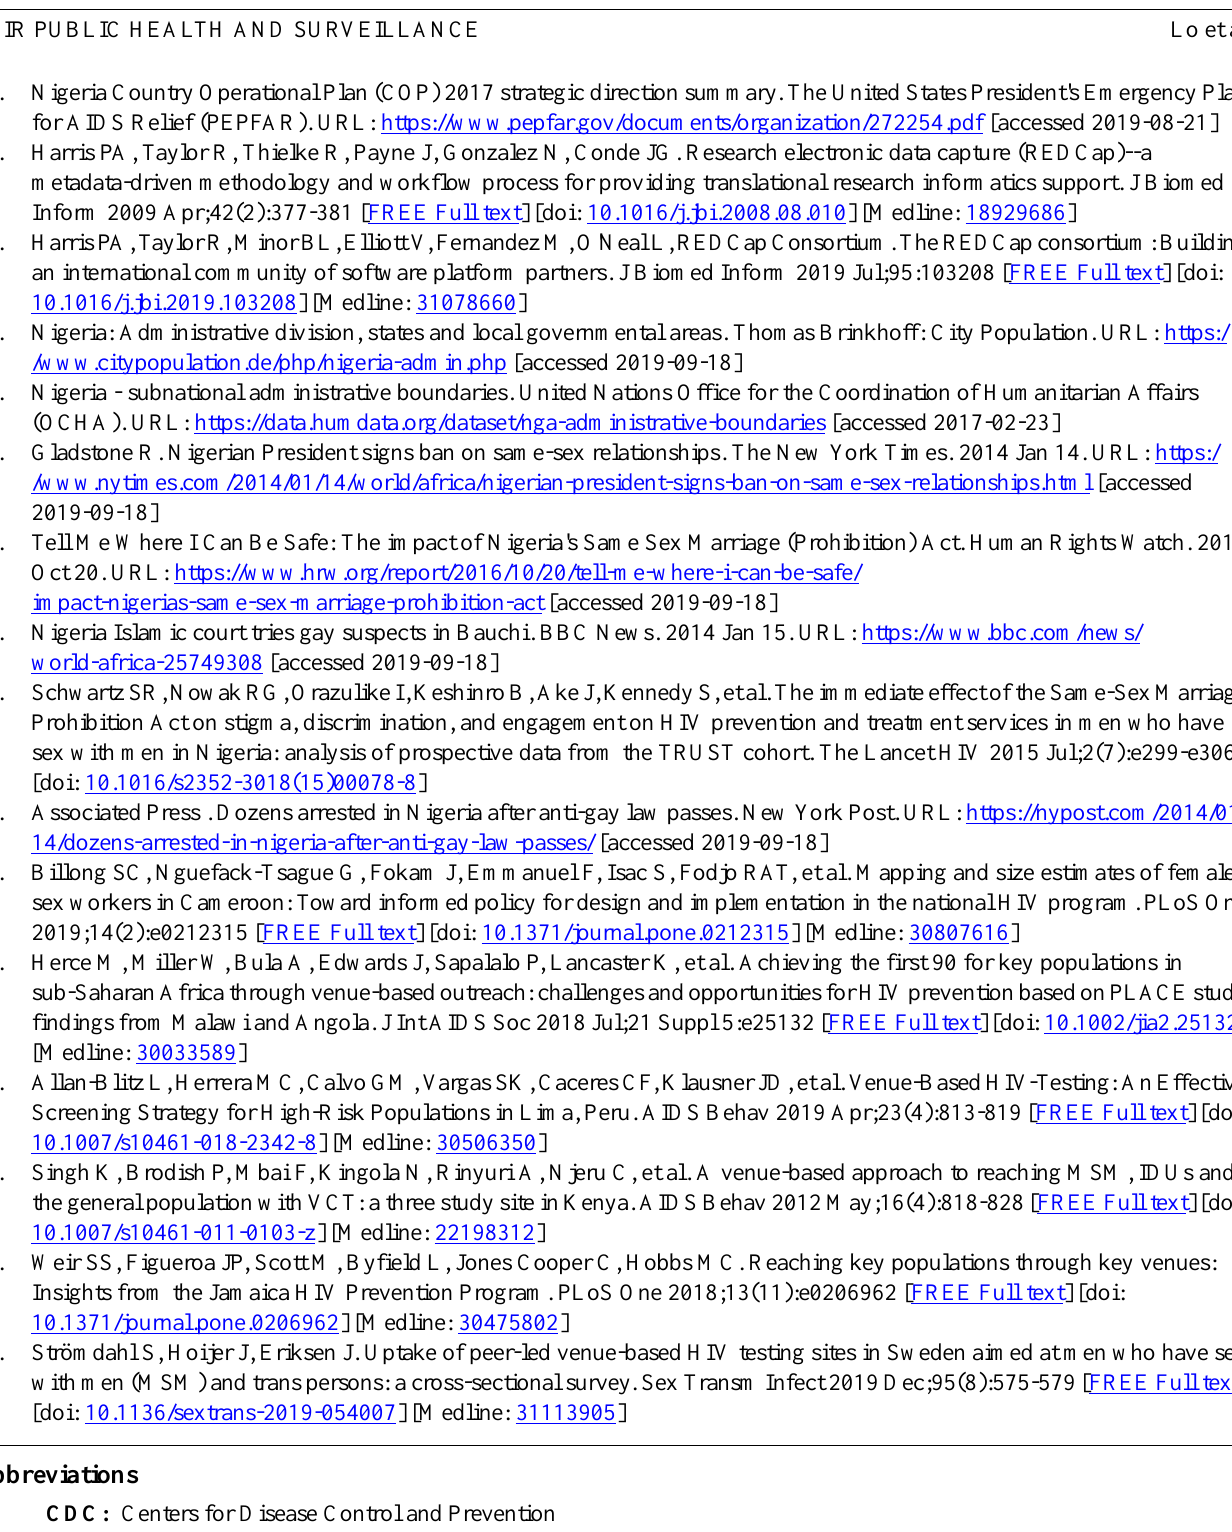
CDC: Centers for Disease Control and Prevention MS-CRC: multiple-source capture-recapture NACA: National Agency for Control of AIDS PEPFAR: President’s Emergency Plan for AIDS Relief REDCap: Research Electronic Data